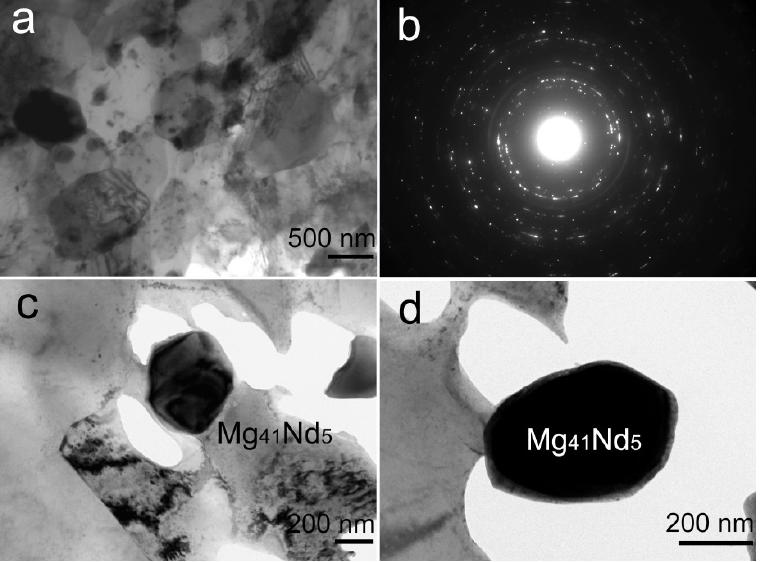
Figure 3. The structure of the WE43 alloy after MAD ( a ), as well as the diffraction pattern from the image obtained ( b ); particles of the Mg 41 Nd 5 phase ( c , d ).